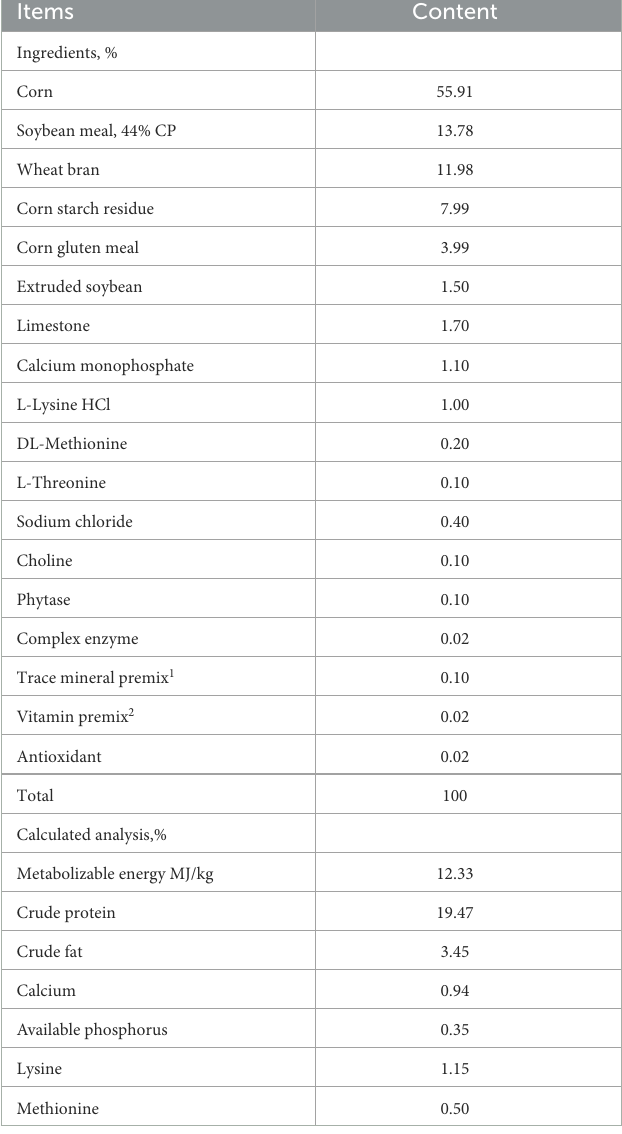
TABLE 1 Composition and nutrient contents of the basal diets (air-dried